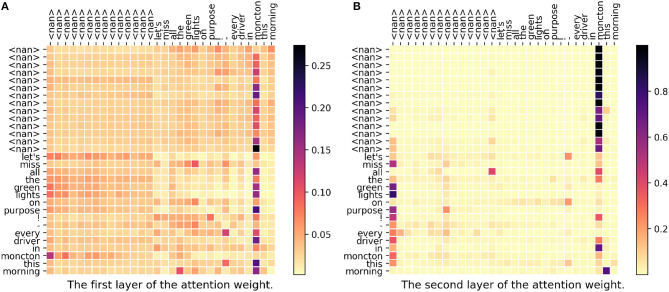
(A,B) The attention weight matrix of our model. <nan> is the padding term since the word length is <30. In this case, DeepGeo, CNN and the proposed method correctly predict moncton-04-ca but FUJIXEROX predicts los angeles-ca037-us.